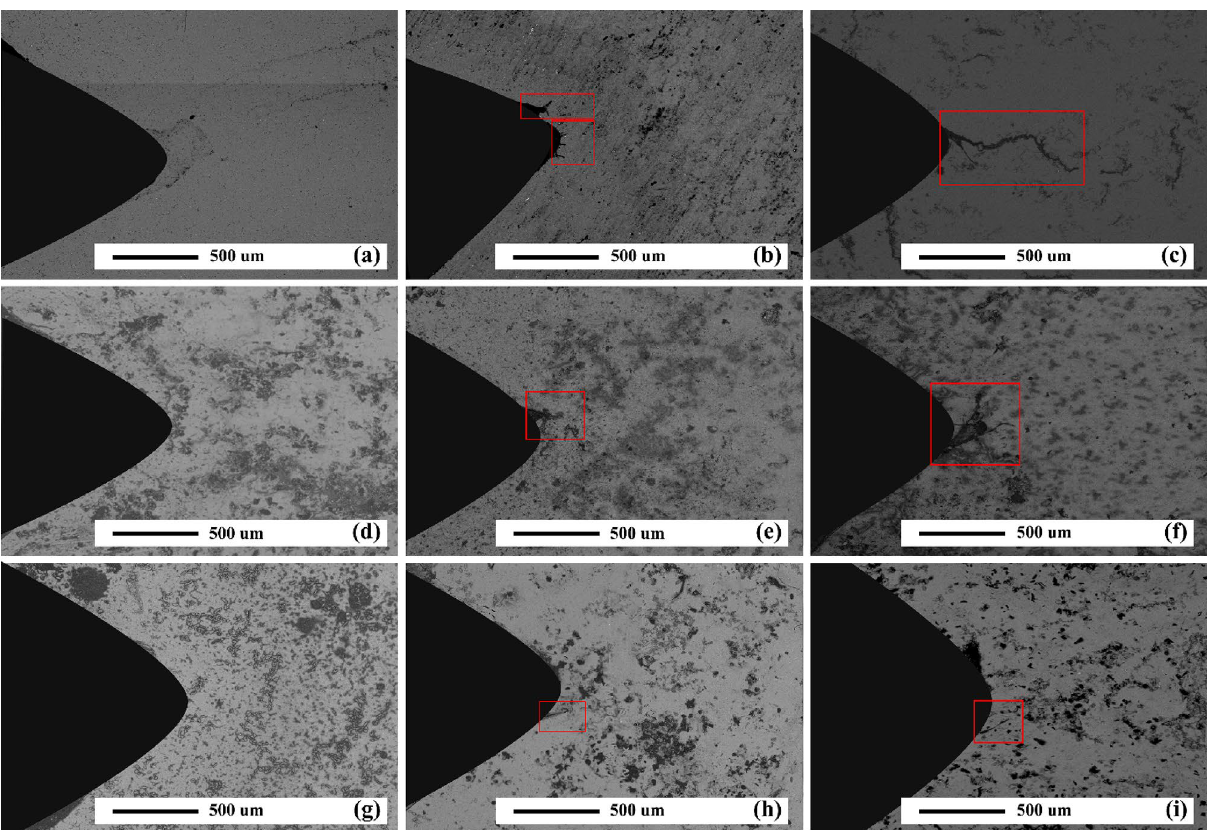
Figure 16. SEM micrographs of aged samples after thermal cycles at 350 °C: ( a ) unreinforced alloy after 300 cycles, ( b ) unreinforced alloy after 600 cycles, ( c ) unreinforced alloy after 900 cycles, ( d ) AZ31/5%SiC after 300 cycles, ( e ) AZ31/5%SiC after 600 cycles, ( f ) AZ31/5%SiC after 300 cycles, ( g ) AZ31/10%SiC after 300 cycles, ( h ) AZ31/10%SiC after 600 cycles, and ( i ) AZ31/10%SiC after 900